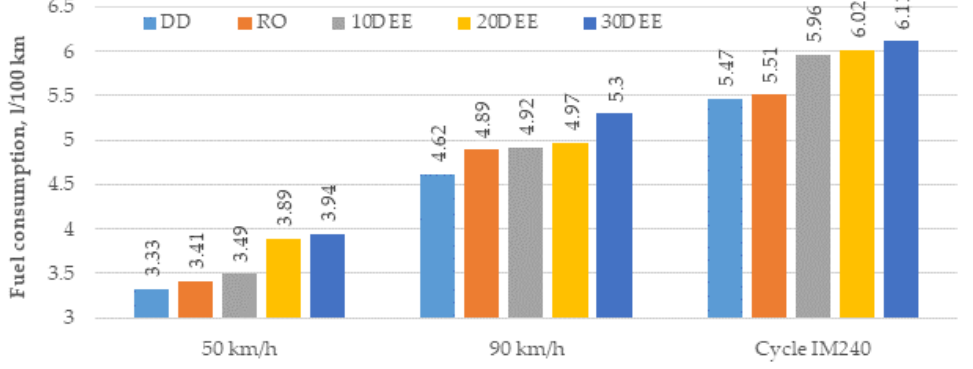
Figure 4. Fuel consumption of diesel fuel (DD), rapeseed oil (RO) and DEE/RO blends